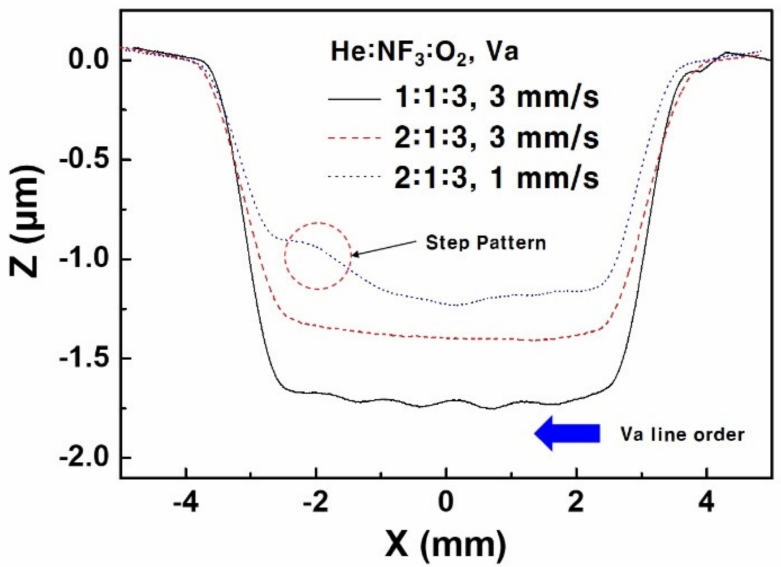
Figure 8. Etch profile stability comparison, black solid: He:NF 3 :O 2 1:1:3 (slm:sccm:sccm), Va 3 mm/s, red dash: 2:1:3, Va 3 mm/s, blue dot: 2:1:3, Va 1